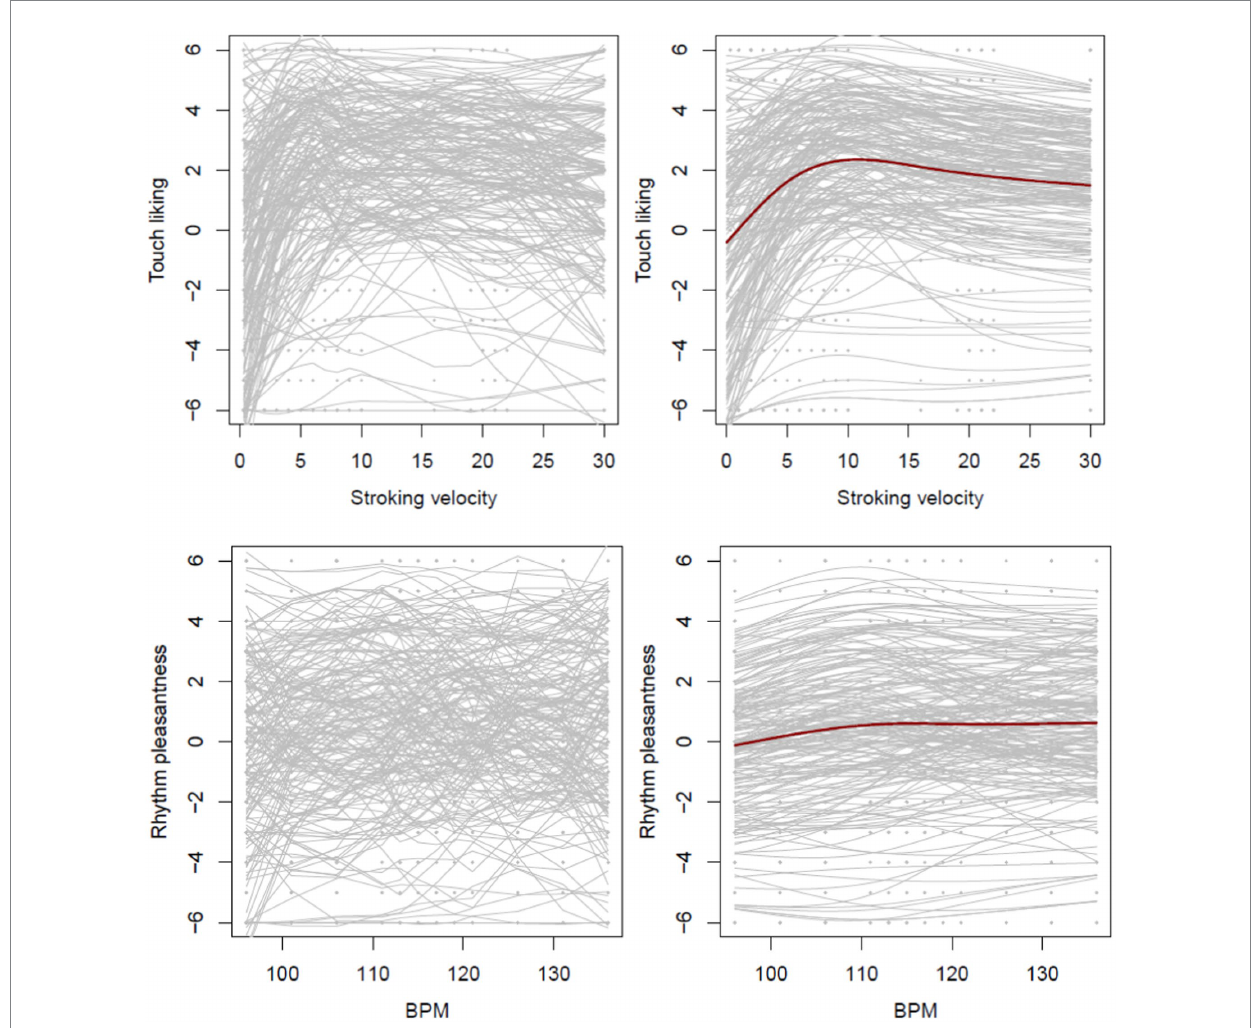
FIGURE 12 Individual curves for touch (upper) and beats (lower). The left column shows curved as observed in the data (loess-smoothed), and the right column shows curves as estimated with the model (right). The mean estimate across all participants is displayed in dark